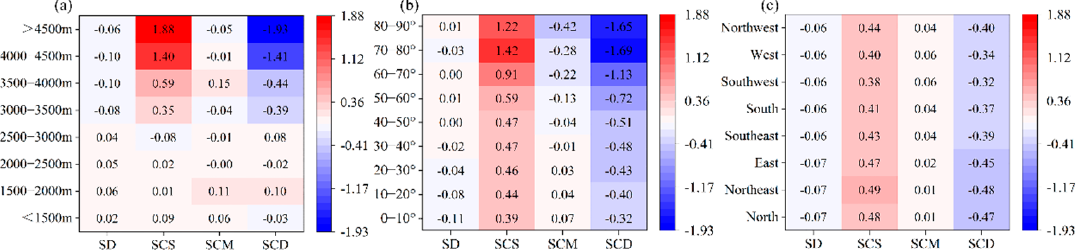
Figure 10. Quantified annual variation in SD (cm/a), SCS (d/a), SCM (d/a), and SCD (d/a) corresponding to the terrain factors of the SGP. Subplots ( a – c ) represent zonal statistics based on the reclassified altitude, slope and aspect, respectively.